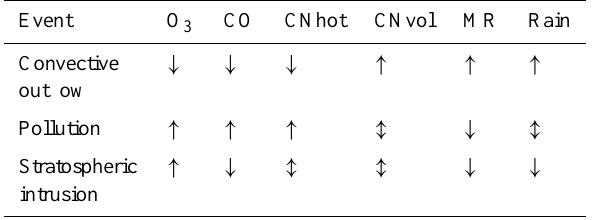
Table 1. Behavior of selected aerosol and gas tracers plus GDAS precipitation when traversing FT features/layers. Increase/decrease of tracer concentrations is indicated in comparison to FT environ-